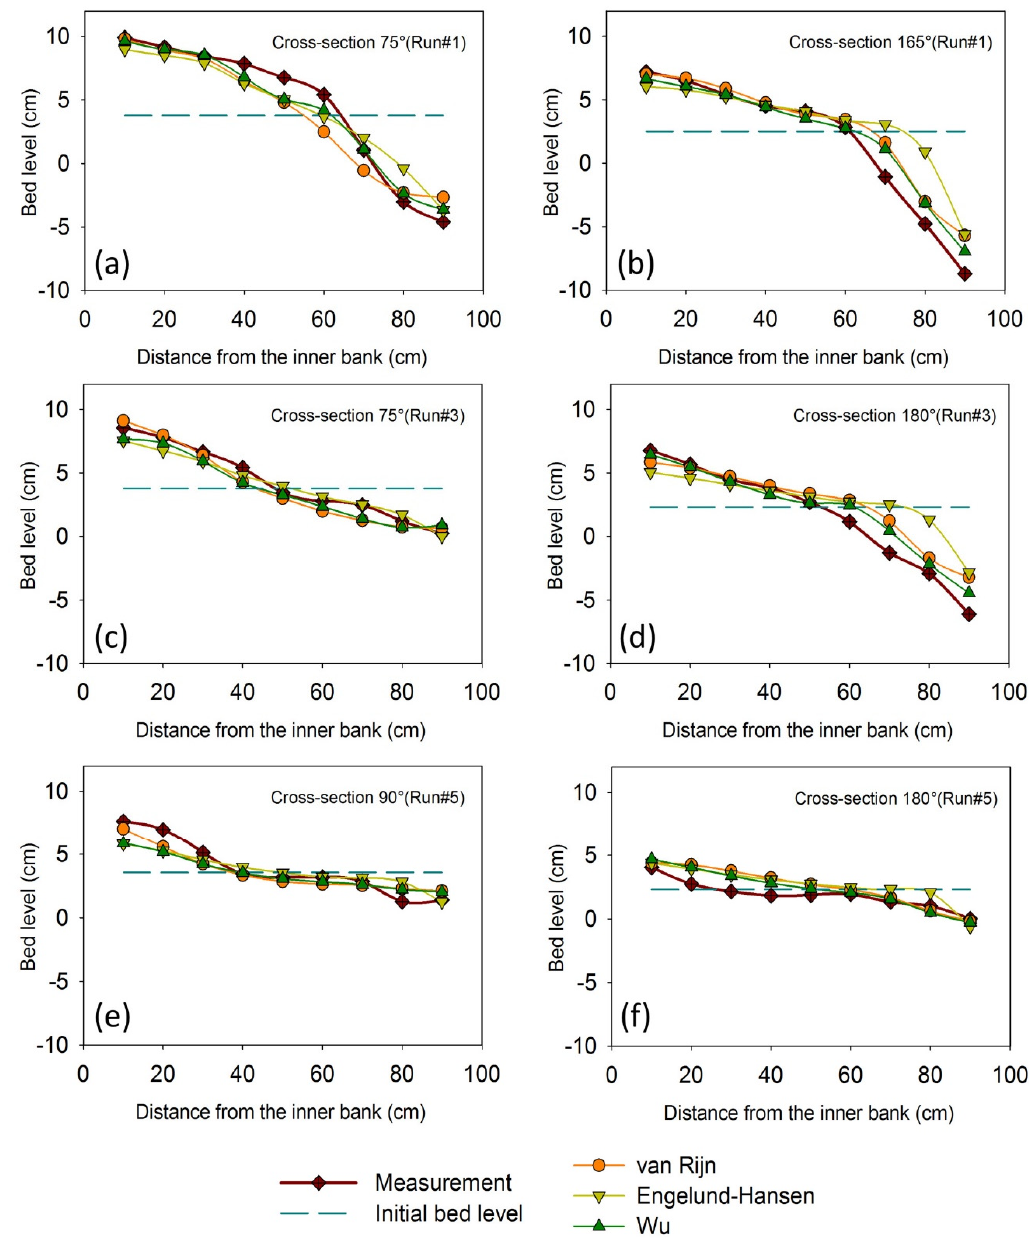
Figure 4. Cross-sectional bed levels for all runs in the maximum deposition ( a , c , and e ) and erosion ( b , d , and f ) sections according to the experiments.